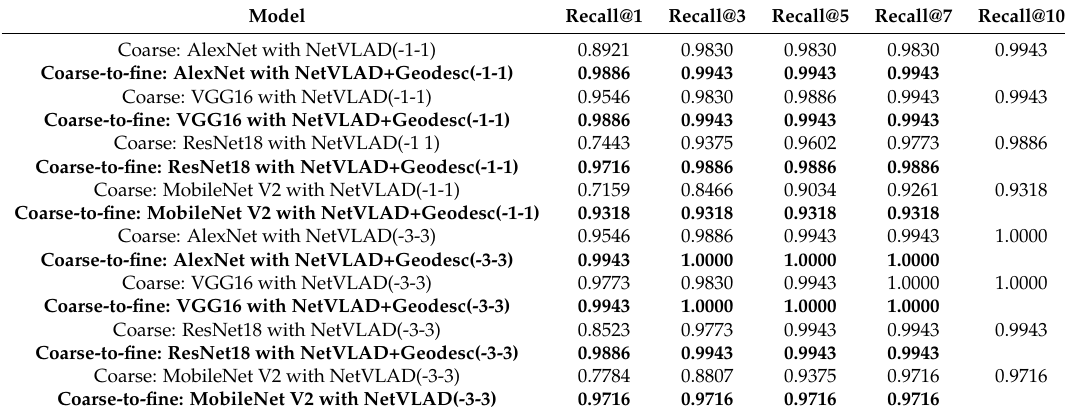
Table 7. Localization results of a coarse-to-fine system on the Chengyuan dataset across summer and winter—subset 2 as query, subset 1 as